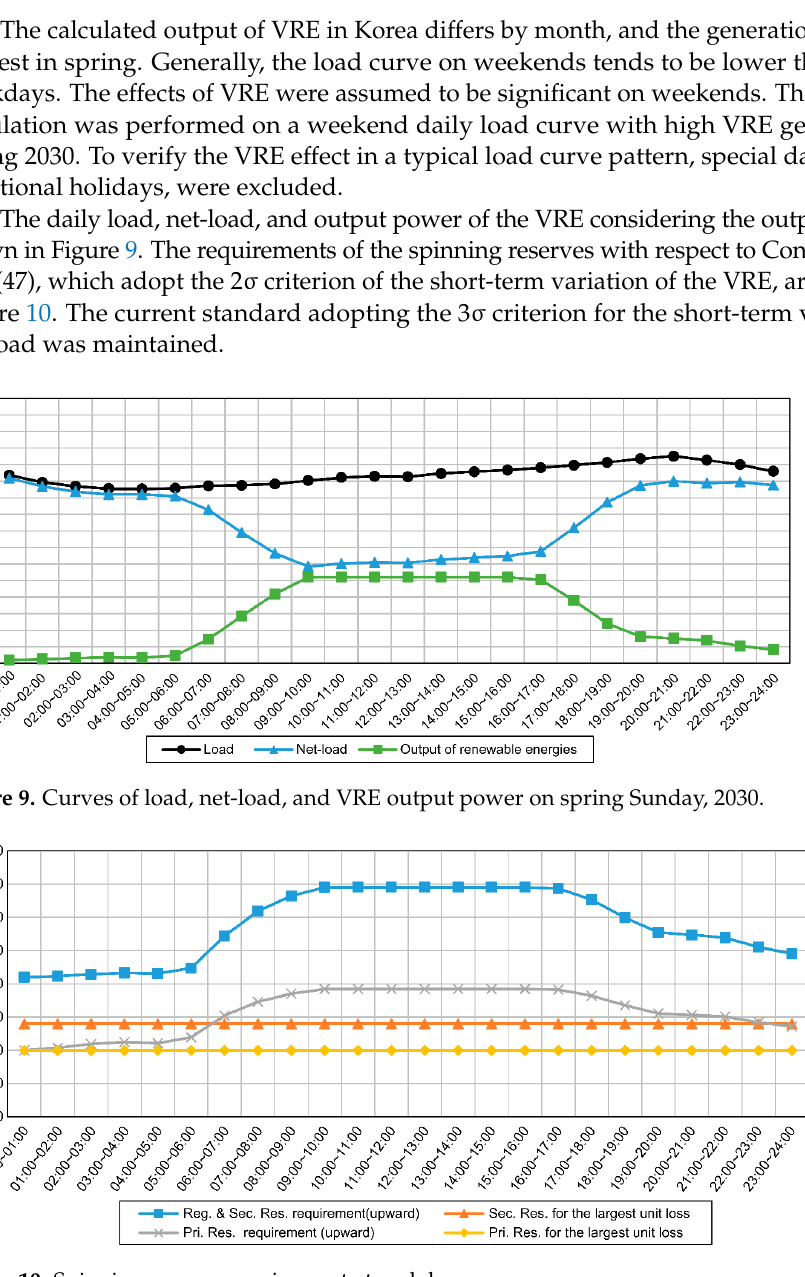
Figure 8. Output and duration curve of 2030 VRE with an output limit of 26 GW.